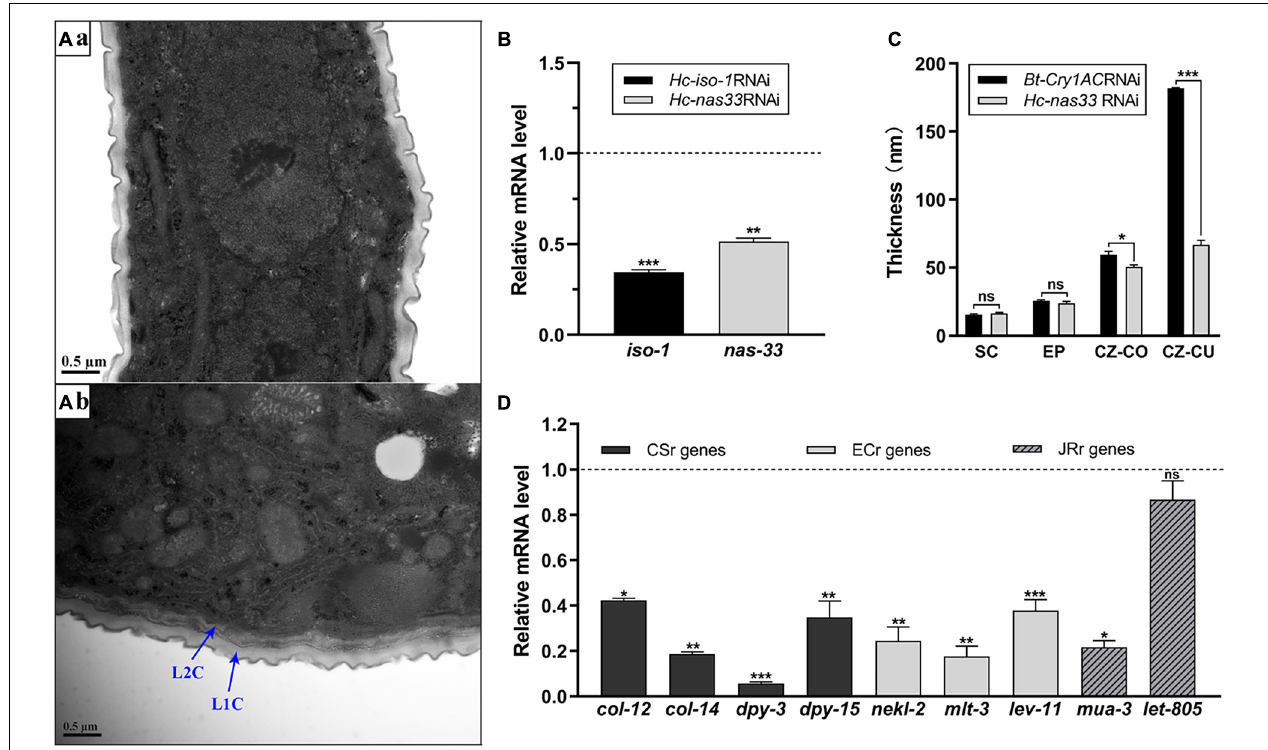
FIGURE 2 | Structural and transcriptional analyses of RNA interference-treated Haemonchus contortus . (A) Transmission electron microscopy of Bt-Cry1AC RNAi-treated (a) and nas-33 RNAi-treated (b) worms. Scale bar: 0.5 µ m. L1C: L1 cuticle; L2C: L2 cuticle. (B) Gene knockdown analysis of iso-1 (positive control) and nas-33 in RNAi-treated worms, with reference to the transcriptions of these genes in the untreated worms. (C) Cuticle thickness (measured by ImageJ) of the second larval stage of H. contortus after RNAi. SC, surface coat; EP, epicuticle; CZ-CO, collagen rich layer of cortical zone; CZ-CU, cuticlin rich layer of cortical zone. (D) Relative transcriptional changes of molting related genes in RNAi-treated worms, compared with that in untreated worms. CSr genes, cuticle synthesis related genes ( col-12 , col-14 , dpy-3 , dpy-15 ); ECr genes, ecdysis related genes ( nekl-2 , mlt-3 , lev-11 ); JRr genes, junction remodeling related genes ( mua-3 , let-805 ). Student’s t -test is used for the statistical analysis between treated and untreated worms. * P < 0.05; ** P < 0.01; *** P < 0.001; ns, no significance. Dotted line represents the transcriptional level in negative control worms.